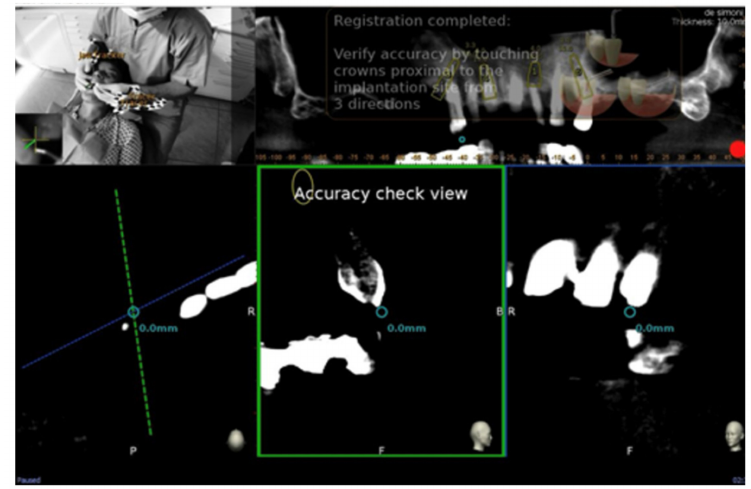
Figure 4. The surgeon can then verify the registration accuracy by touching with the tracer’s ball tip on the patient’s landmark from several aspects and comparing the physical location of the tip with its on-screen representation on the system’s